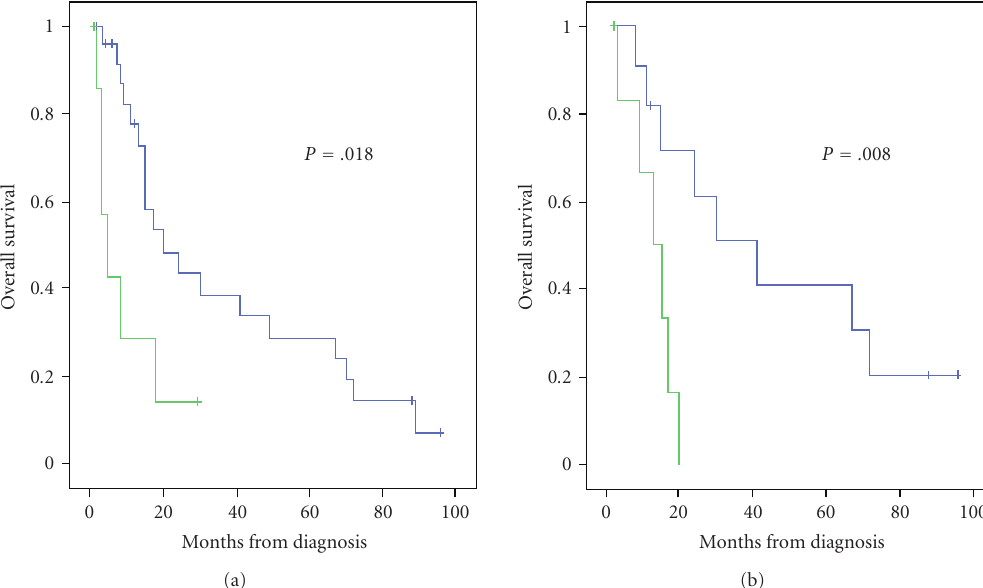
Figure 3: (a): patients with metastatic disease at presentation had worse overall survival than those with no metastatic disease (median survival for 5 months versus 20 months, resp., P = . 018). (b): patients with microscopic or gross residual disease after surgery had worse overall survival than those with microscopically negative margins after surgery (median survival for 13 months versus 41 months, resp., P = .